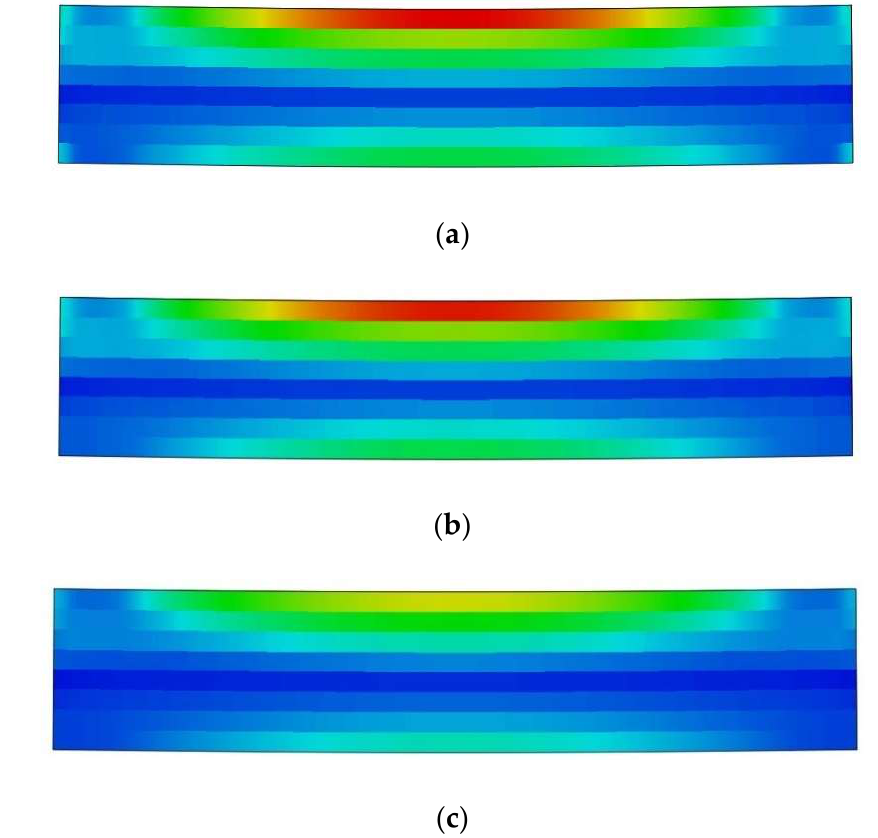
Figure 16. Tsai–Hill criterion maps: ( a ) model_1 (fi = 0.25 mm); ( b ) model_2 (fi = 0.19 mm); and ( c ) model_3 (fi = 0.15 mm).